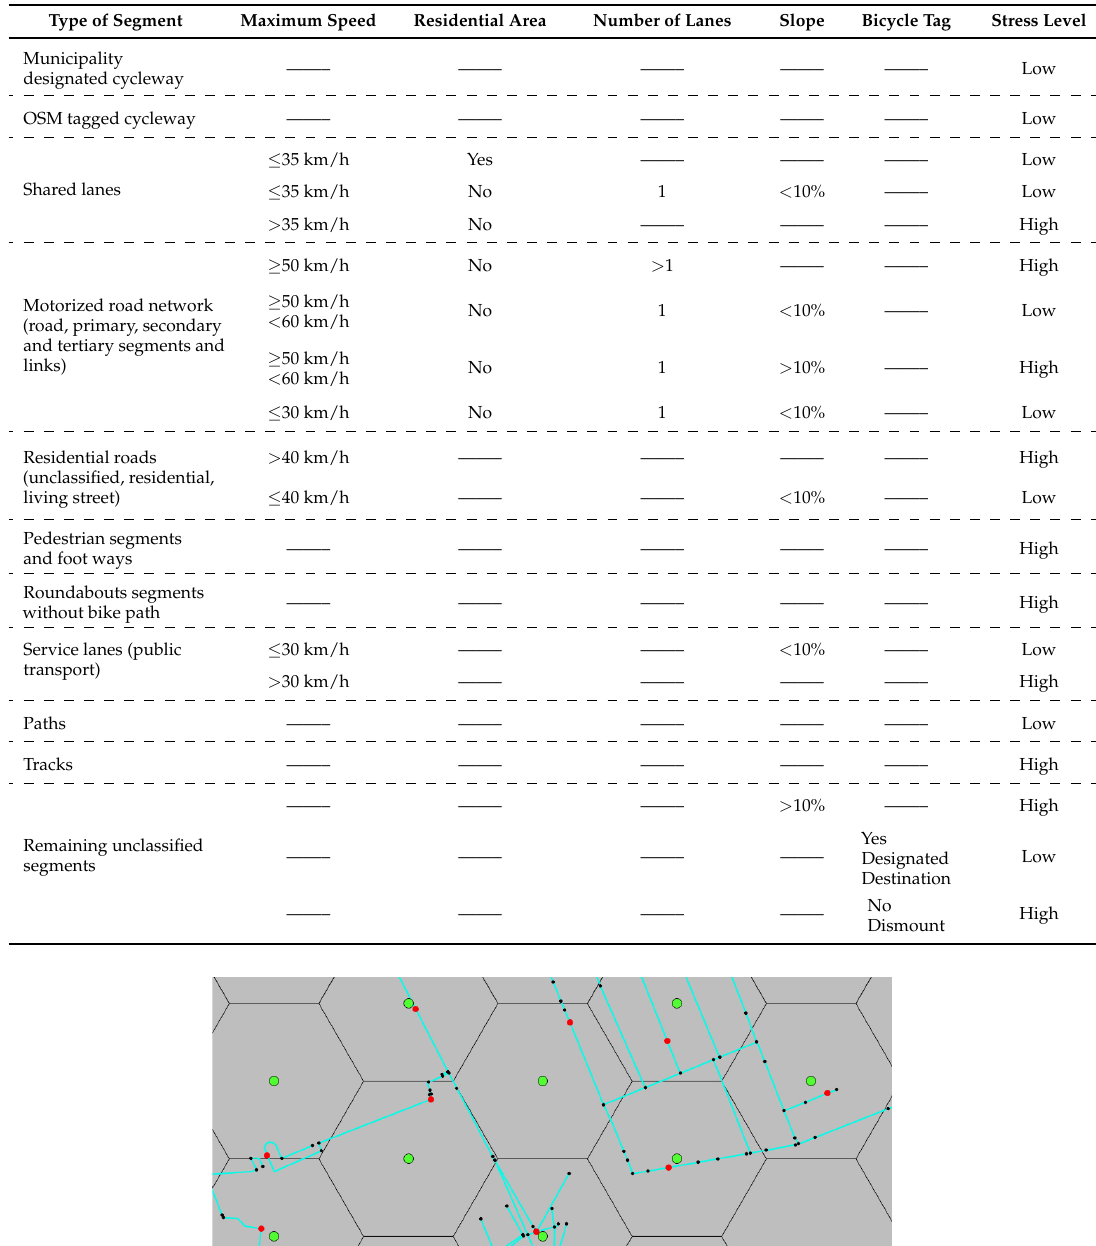
Table 1. Classification criteria for stress level segment labeling.